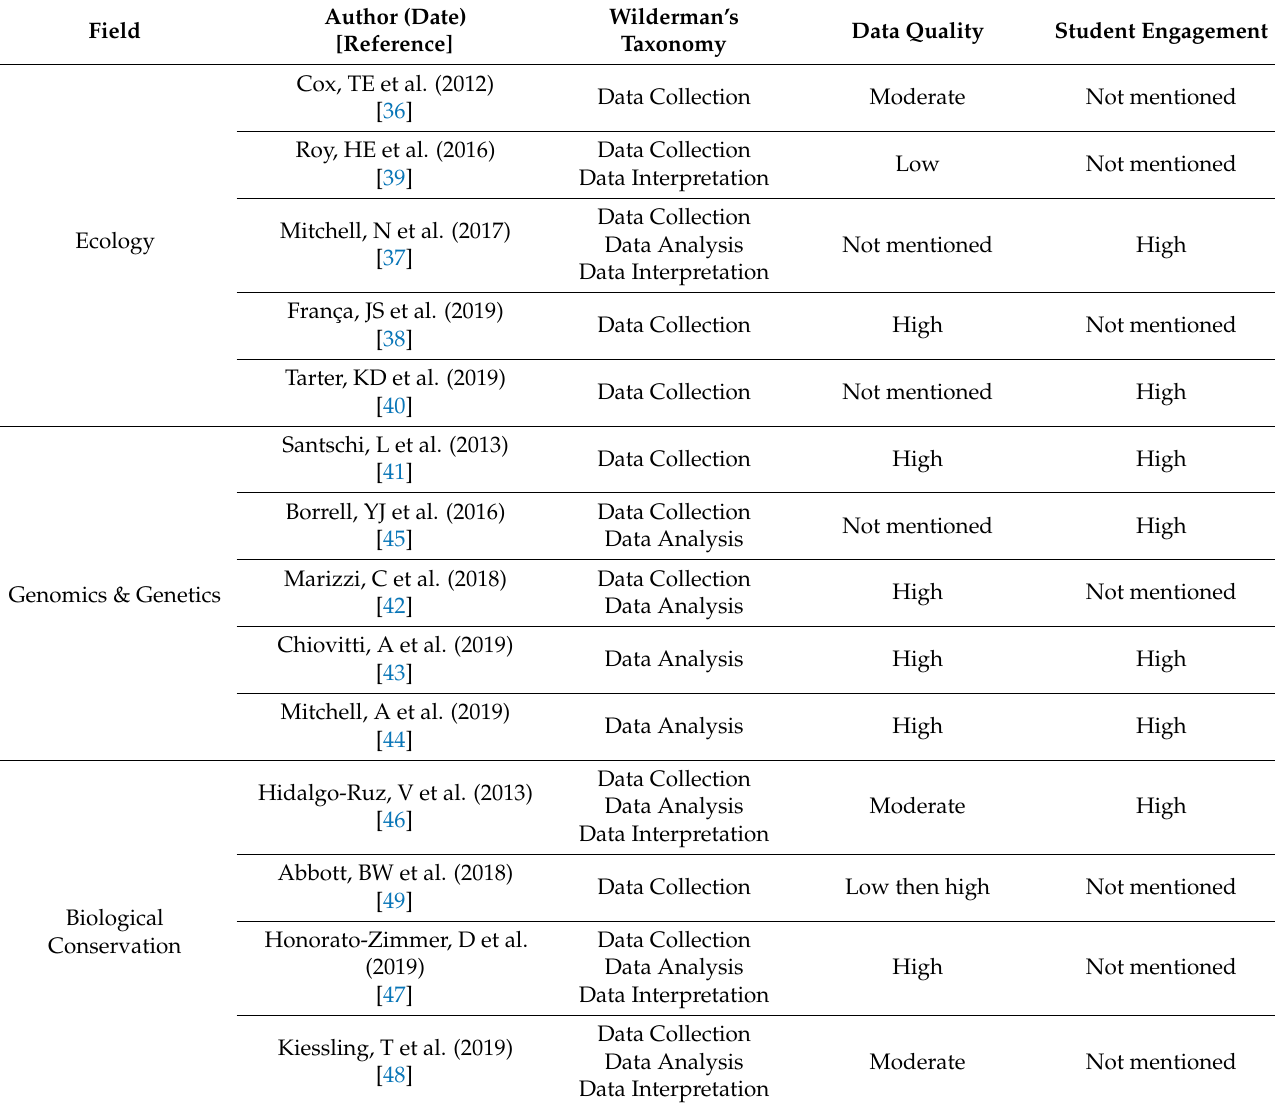
Table 2. Wilderman’s taxonomy and outcome measures of school citizen science